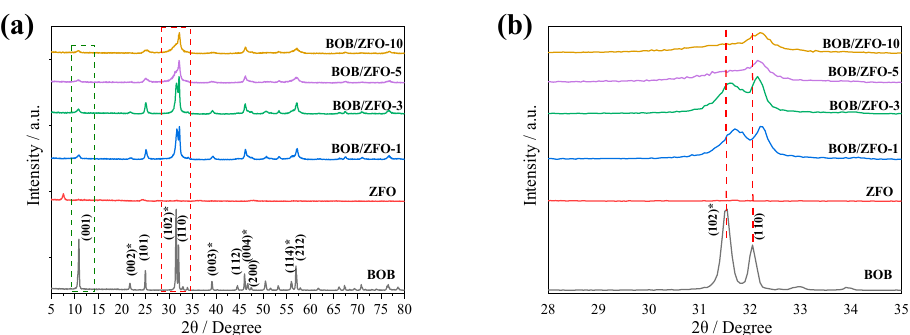
Figure 1. ( a ) XRD patterns of BiOBr, ZnFe 2 O 4 and BOB/ZFO-x nanocomposites; ( b ) amplified XRD patterns of the samples. (The peaks with a “*” in ( a ) indicated that these peaks in the BOB/ZFO-x are decayed obviously compared with pure BiOBr. This is due to the induced effect of ferroelectric ZnFe 2 O 4 , which makes the (110) facet epitaxially grown, resulting in the decrease in the intensities of these peaks.